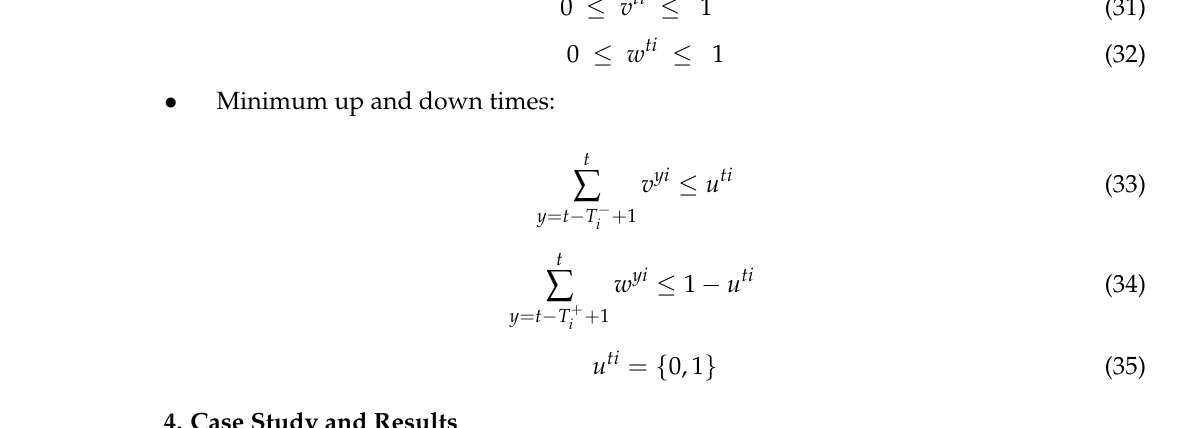
Figure 11. Typical load profile for Pune, India [26]. Table 1. Data for generators. Bus Number Generator Type (Fuel)